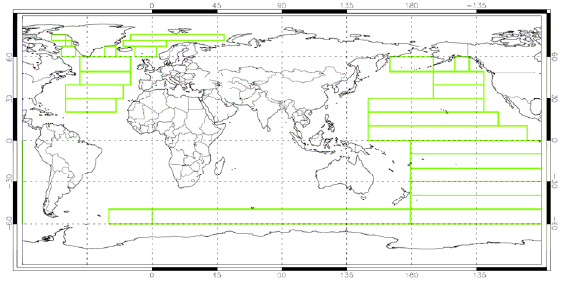
Fig. 2. Latitude bins selected over the remote ocean for the normalization procedure of SCIAMACHY CO VCDs using MOPITT data (see section 3).